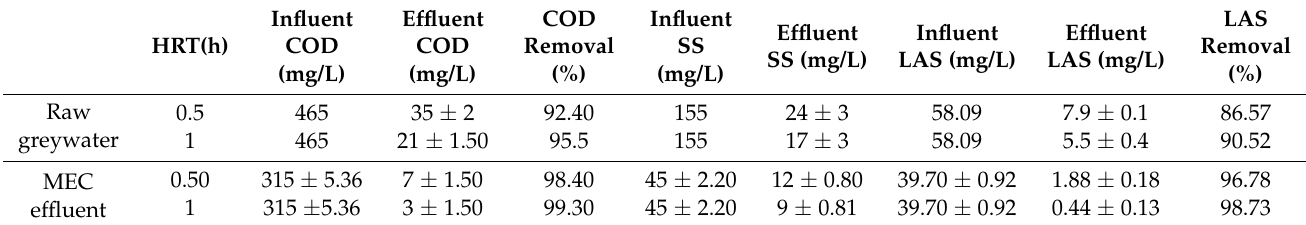
Table 2. Performance of granular activated carbon (GAC)-Biofilter System at different